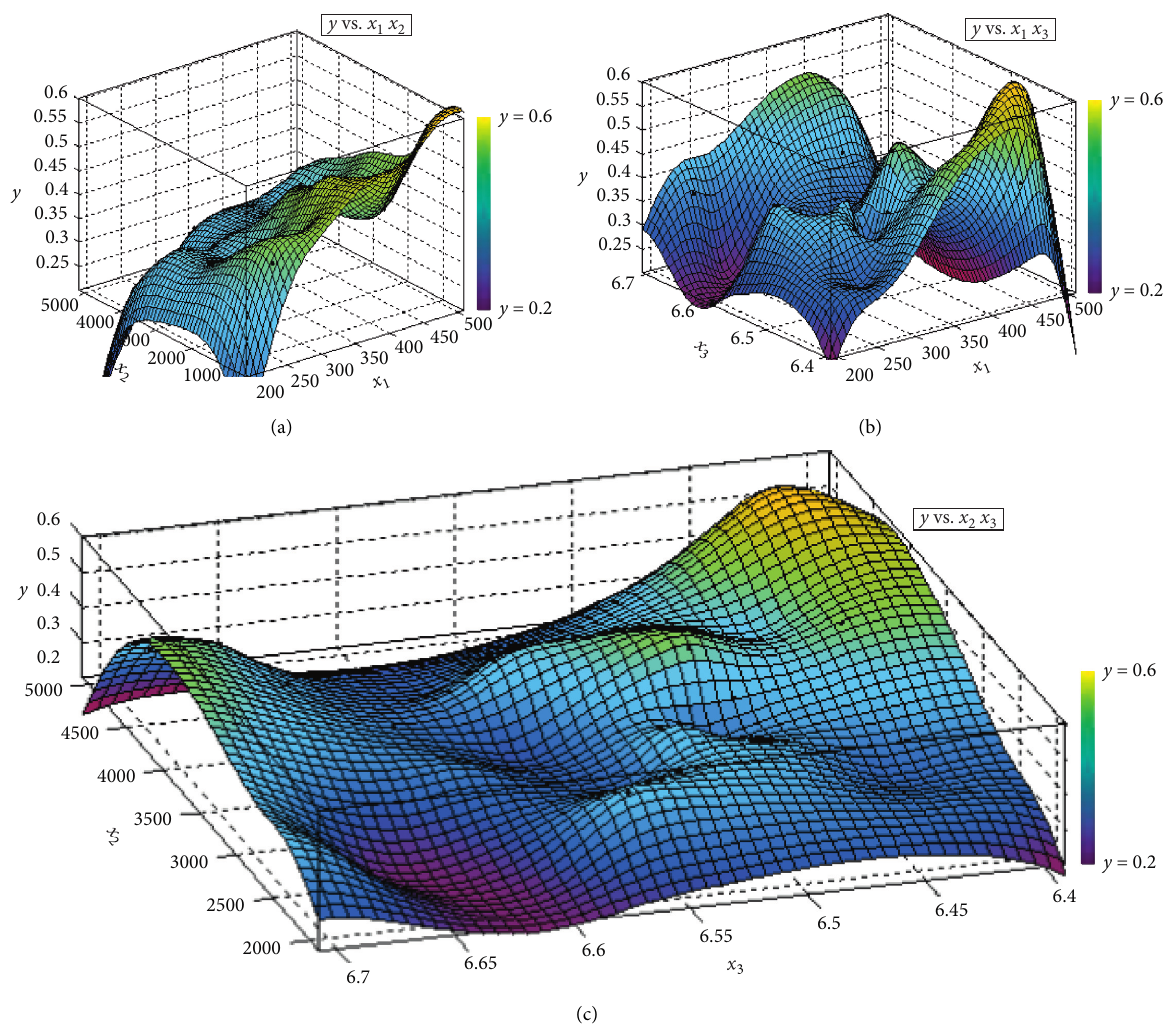
Figure 9: Response surface of design parameters and HsEHV acceleration peak and